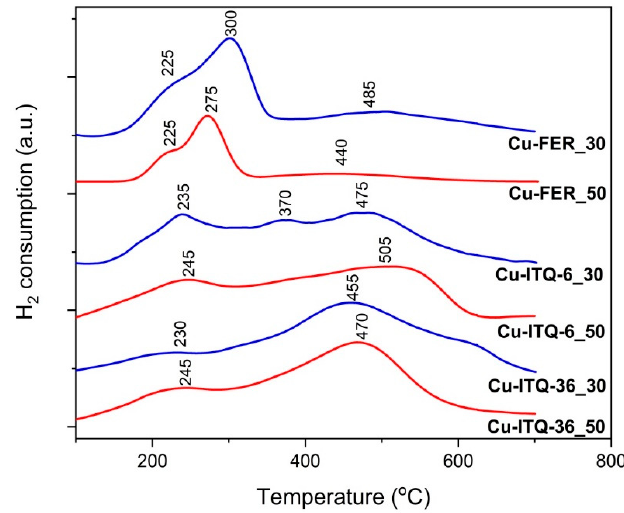
Catalysts 2020 , 10 , x FOR PEER REVIEW 12 of 22 runs. A similar effect was reported and analyzed for the Cu-ZSM-5 samples by Yang et al. [38]. This effect may indicate a very high lability in Cu 2+ → Cu + reduction. Figure 5. UV-vis_DR spectra of FER ( a ), ITQ-6 ( b ) and ITQ-36 ( c ) samples modified with Cu.